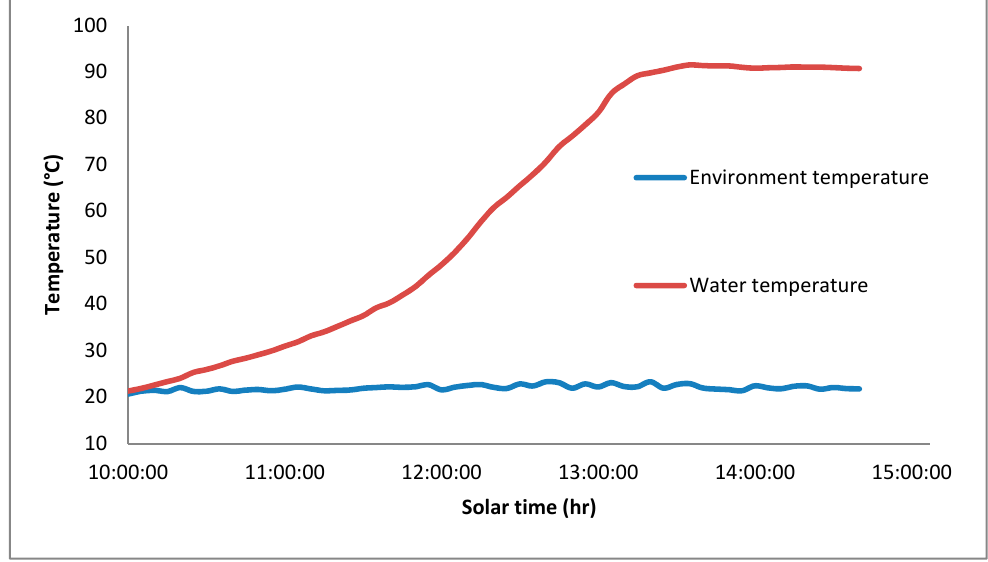
Figure 9. Water temperature in food cooking module.